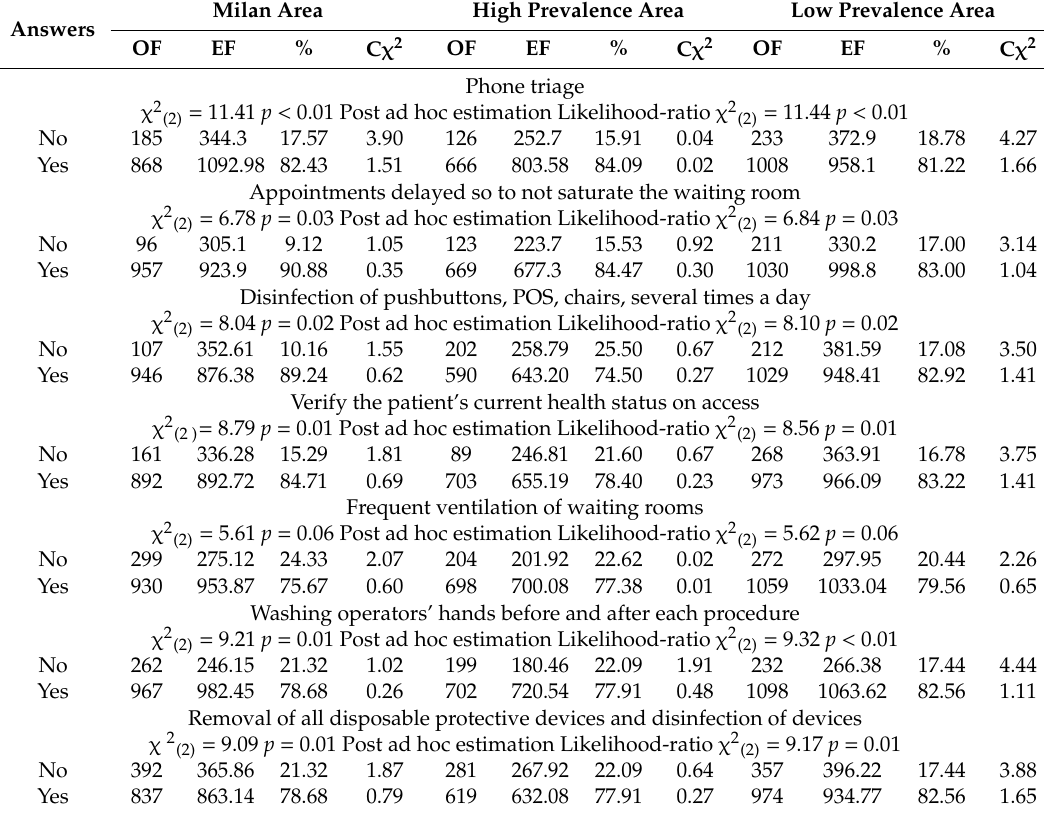
Table 6. Precautionary measures against COVID-19 stratified by areas with di ff erent prevalence of the disease. The items with 80% or more positive replies were used. Percentages were calculated per column.